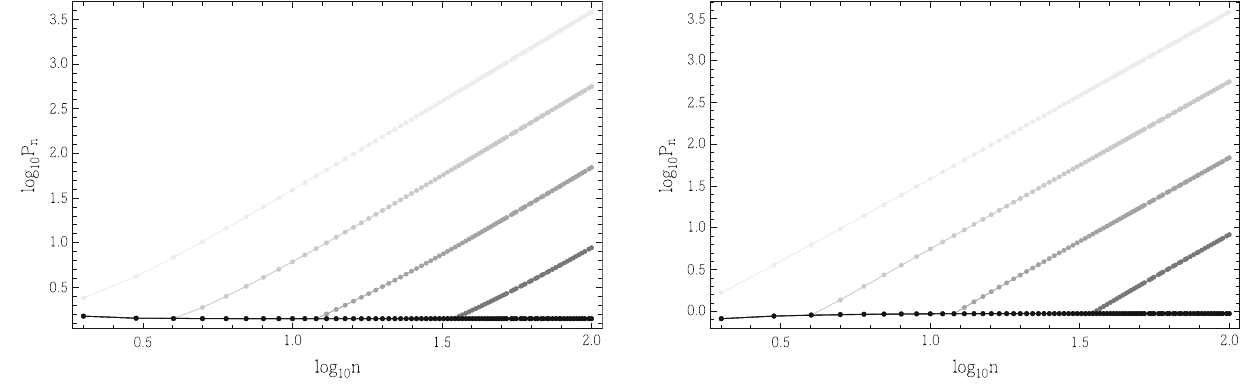
Fig. 4 The time evolution of power spectrum in the case of ˜ m = 0, √ H 0 = 8 π/ 3. The darker curves correspond to the spectra at later times. The lightest curve is the initial Lorentzian spectrum at time t i . For each n mode, the power is evaluated up to its horizon crossing time